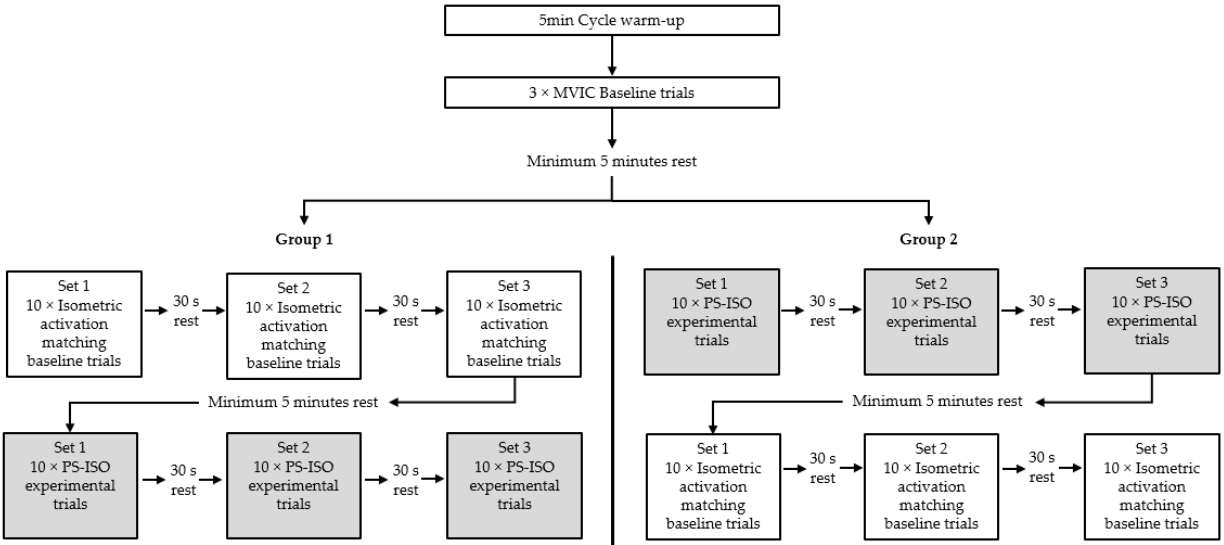
Figure 1. Baseline and experimental protocols for Group 1 and Group 2. Participants were randomly allocated into each group.